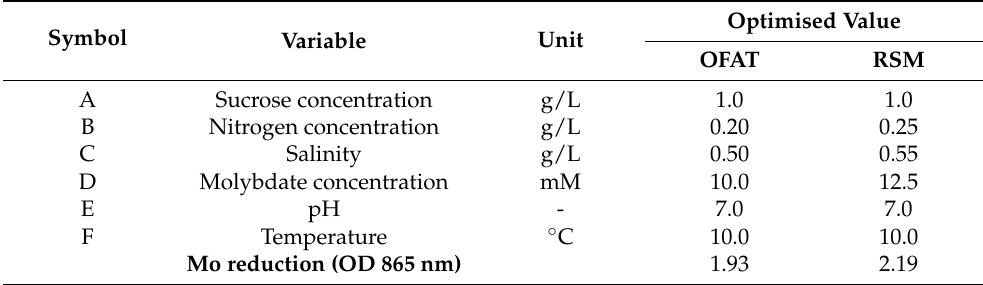
Table 4. Optimised condition obtained using OFAT and RSM for Mo reduction using Arthrobacter sp. strain